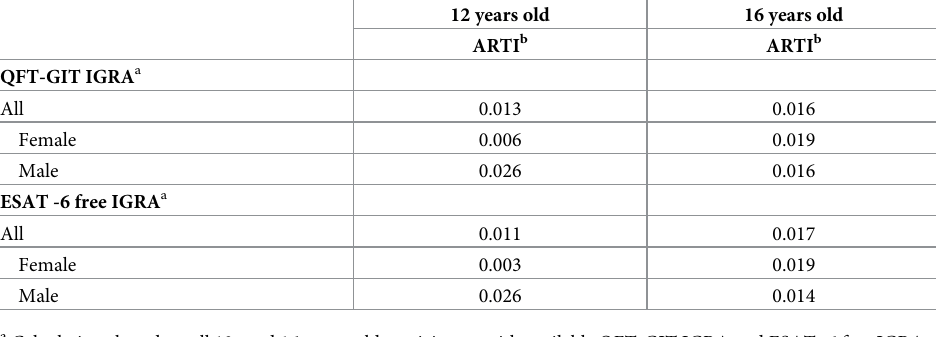
Table 3. Annual risk of tuberculosis infection as measured by QFT-GIT IGRA and ESAT-6 Free